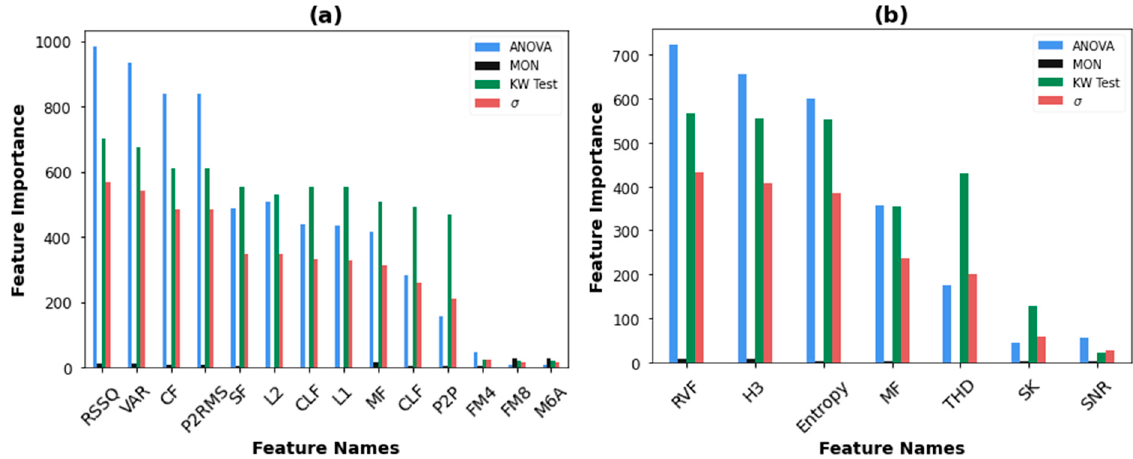
Figure 10. ( a ) Time domain features. ( b ) Frequency domain features.